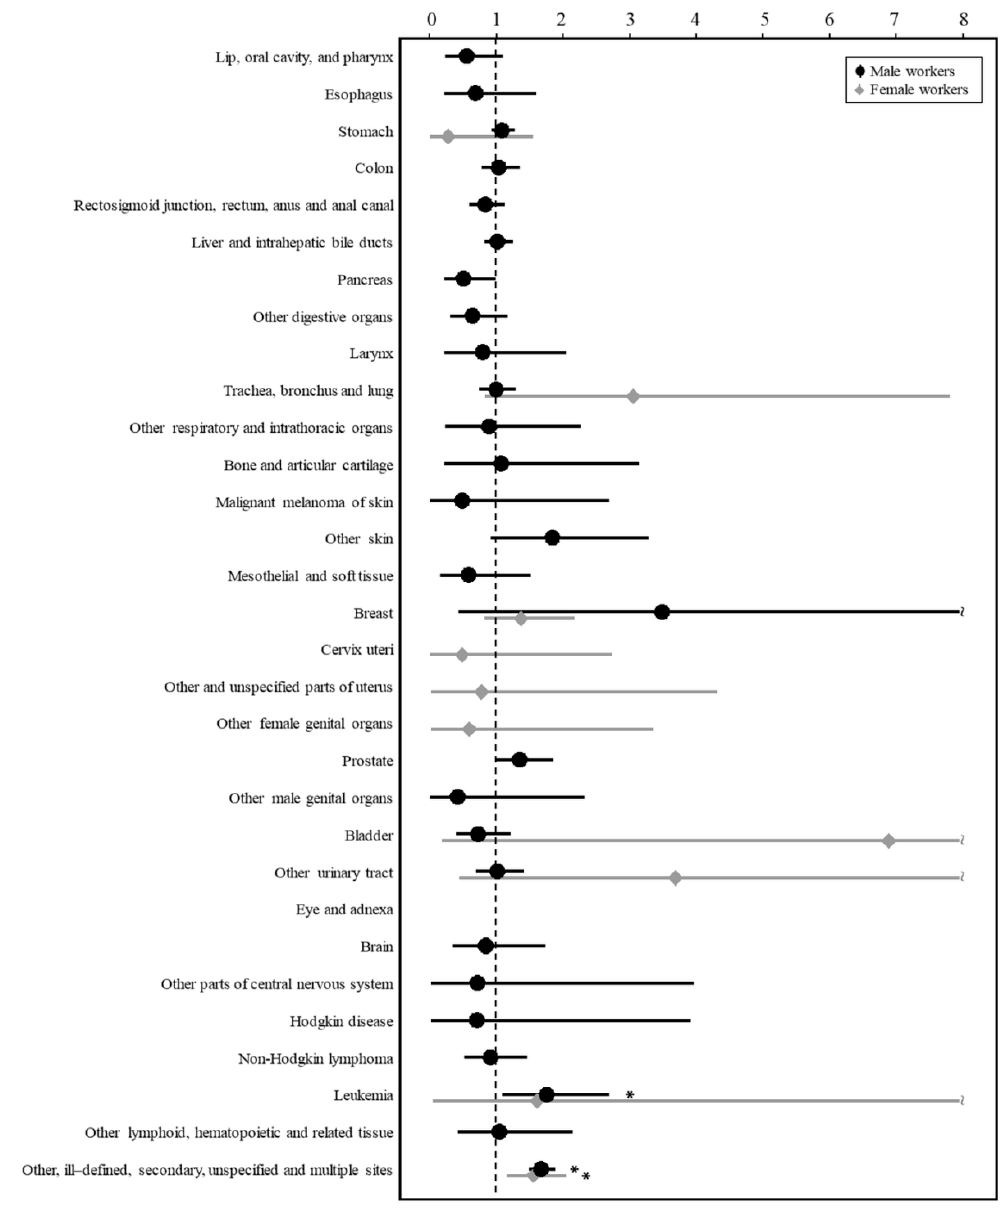
Table 3. The age-standardized Incidence Ratios (SIR) and 95% confidence interval (CI) of the air transportation industry female workers for cancers according to reference group.